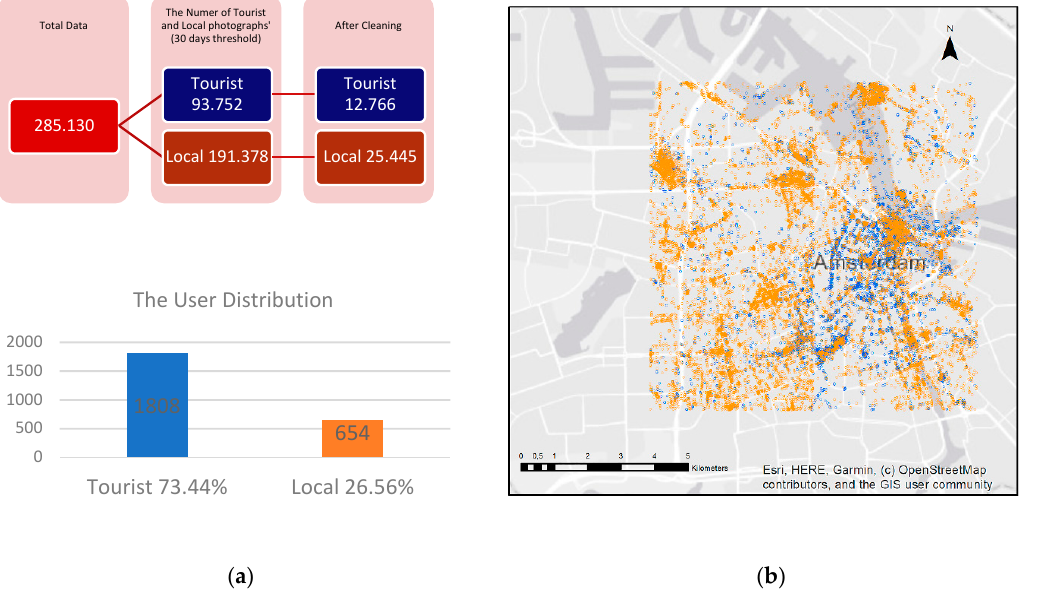
Figure 2. ( a ) Valid photographs and user distribution; ( b ) Flickr photographs. Table 1. Heritage